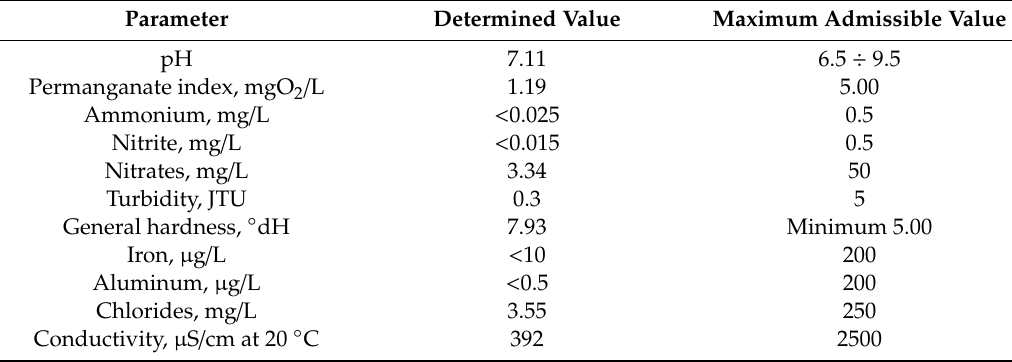
Table 8. Results of the physical-chemical analysis of “Roua Apusenilor” spring